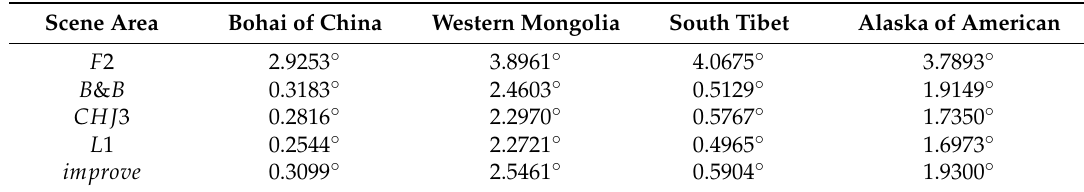
Table 1. The average values of FRA estimates under all